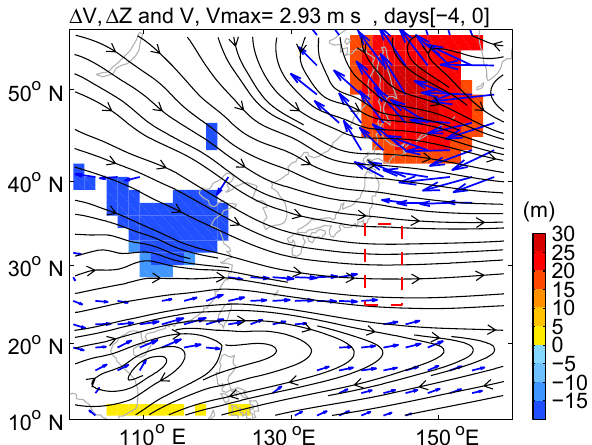
Figure 10. The mean horizontal wind anomalies at 1000–500hPa (in vectors with units of ms − 1 ) and the 1000–500hPa thickness anomalies (in color shading) during days [ − 4, 0]. Only significant (at the 0.1 level) winds and thickness are plotted. The long-term mean horizontal winds between 1000 and 500hPa during days [ − 4, 0] are shown together as the streamlines for comparison. A red dashed rectangle (140–145 ◦ E and 25–35 ◦ N) indicates the central location of the anomalous cyclone, which is significant on day +